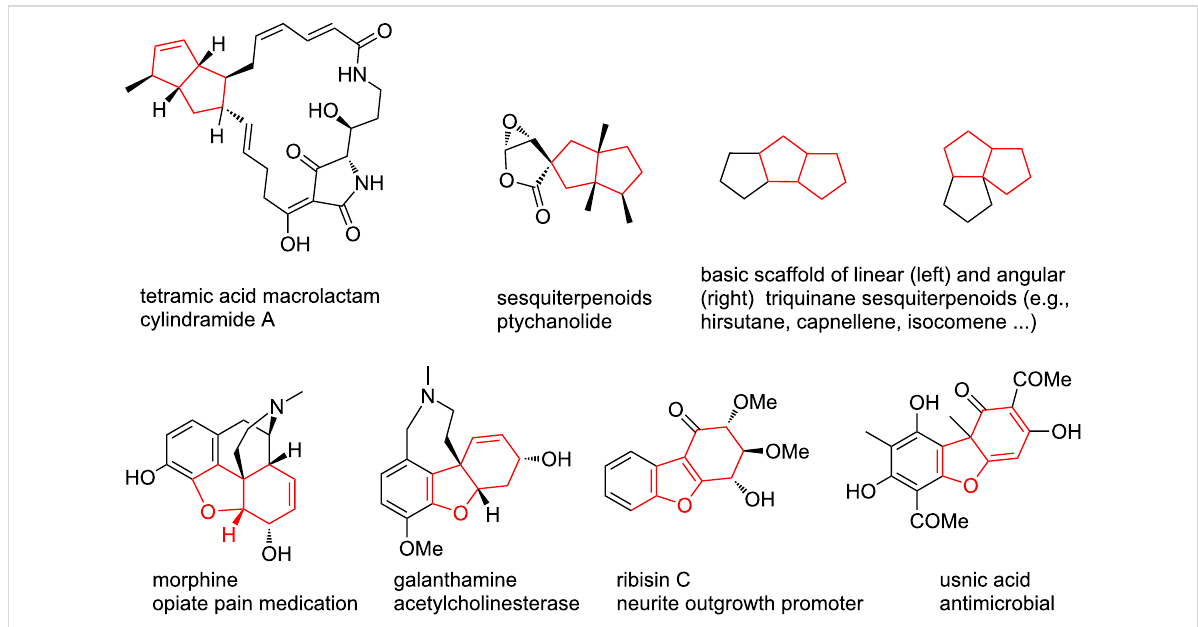
Figure 1: Examples of annulated cylopentanic (top) and furan-based (bottom) substructures in natural